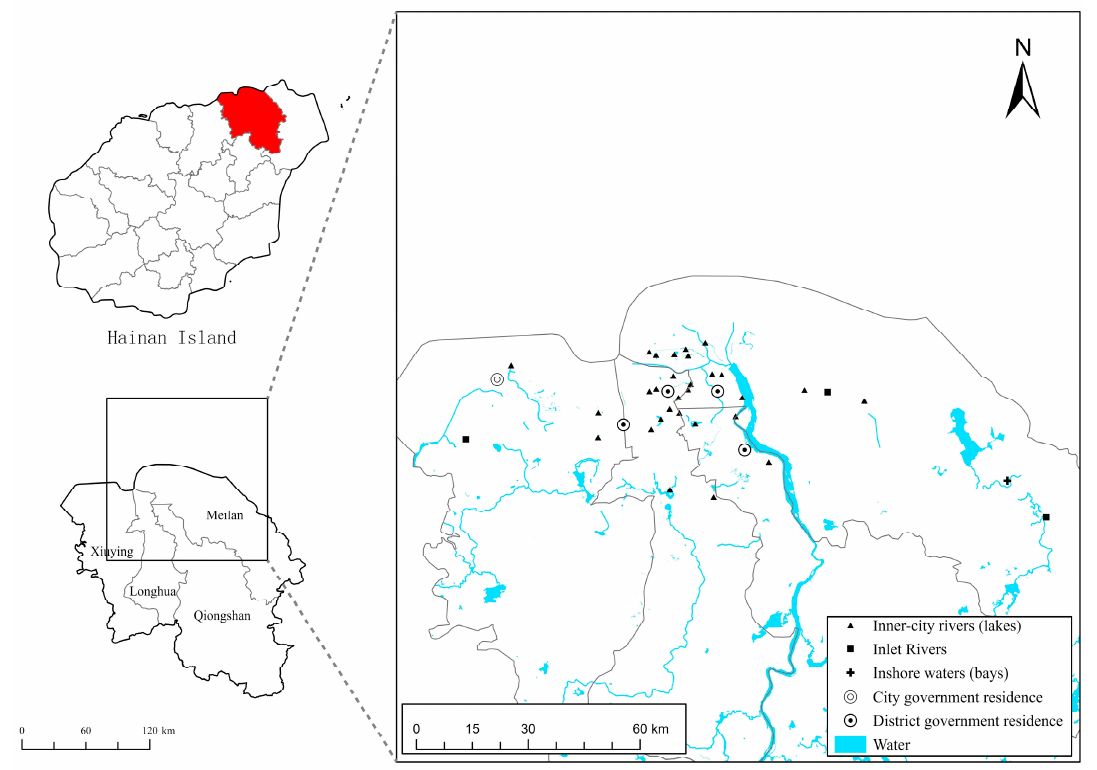
Figure 2. Status of polluted water bodies in Haikou. (The water bodies depicted as polluted on this map are in accordance with the Three-Year Action Plan for the Treatment of Polluted Water Bodies in Hainan Province, issued by the General Office of the Hainan Provincial People’s Government.)